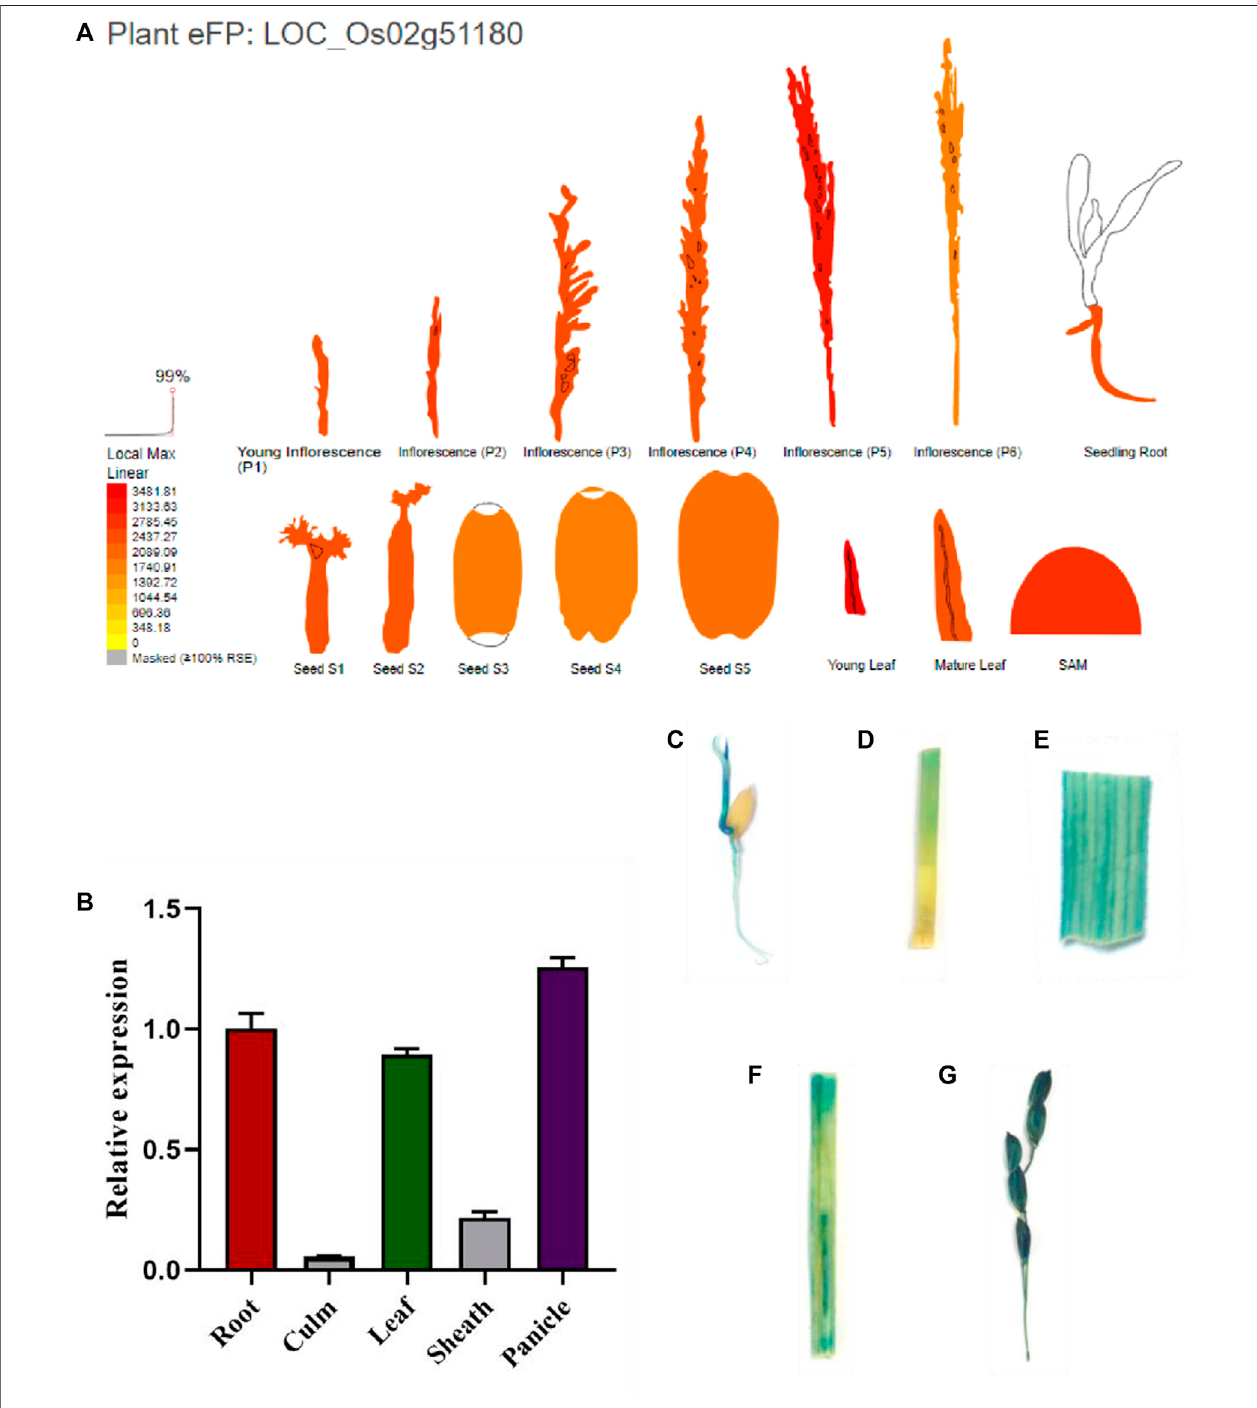
FIGURE 7 | Expression analysis of SPL88 . (A) Site predicts the expression pattern of SPL88 ; (B) expression of SPL88 in various organs of wild-type and mutant plantsanalyzedbyqRT-PCR; (C – G) histochemicalsignalsfromthe SPL88 promoter-GUSreportergene.GUSsignalsweredetectedinrootC,stemD,leafE,leafsheath F, and panicle (G)